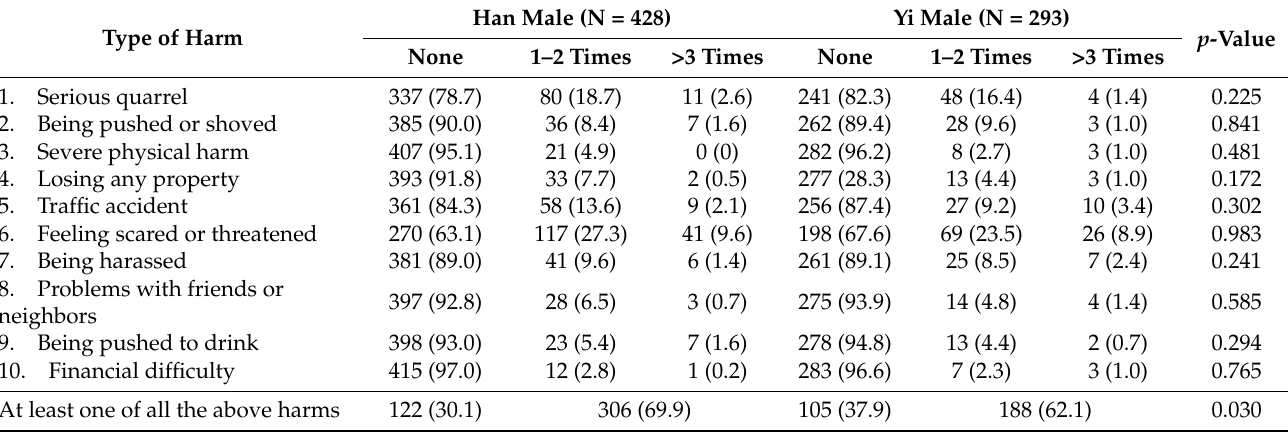
Table 3. Frequency of harm from other’s drinking in the past 12 months among Han and Yi males in rural areas of Chuxiong Yi Autonomous Prefecture (n =